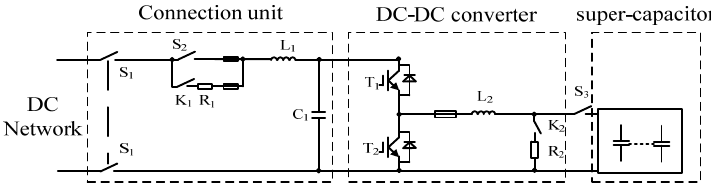
Figure 7. Super-capacitor ESS installed in traction substation.